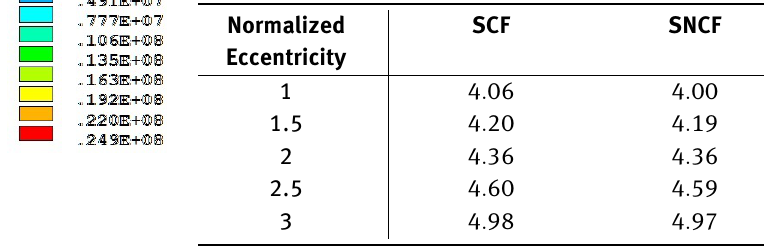
Table 4: Effect of hole eccentricity on stress and strain